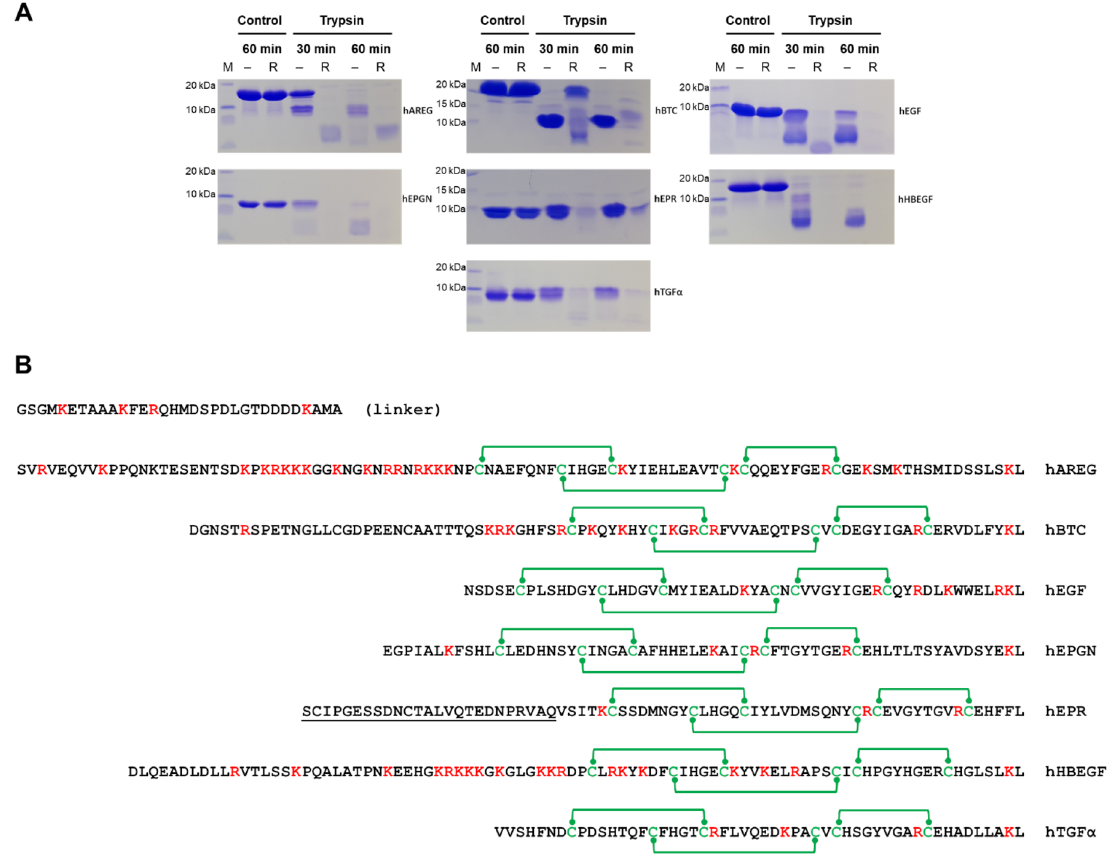
Figure 2. Stability analysis by limited proteolysis using trypsin. The proteolytic assays were performed with samples both untreated and treated with the reducing agent DTT and incubated for 30 and 60 min. Control non-reduced and reduced samples without trypsin treatment were incubated under the same conditions. ( A ) The panels show Coomassie stained SDS–polyacrylamide gels used for the analysis of the proteolysis products and control reactions of the EGF growth factors as identified on the right side of each panel. M, molecular mass markers. -, non-reducing condition. R, reducing condition. Only the relevant parts of the gels are shown. Original uncropped images of the gels are presented in the Supplementary Information file, Figure S2. ( B ) Sequences of the EGF domains with the basic residues target of trypsin marked in red and the cysteine residues marked in green. Green lines indicate the disulfide bonds. The sequence identified by (linker) represents the part of the linker encoded by the vector which remains attached to the growth factors after thrombin digestion. The underlined EPR region indicates the segment of the hEPR propeptide required for stable expression of this EGF growth